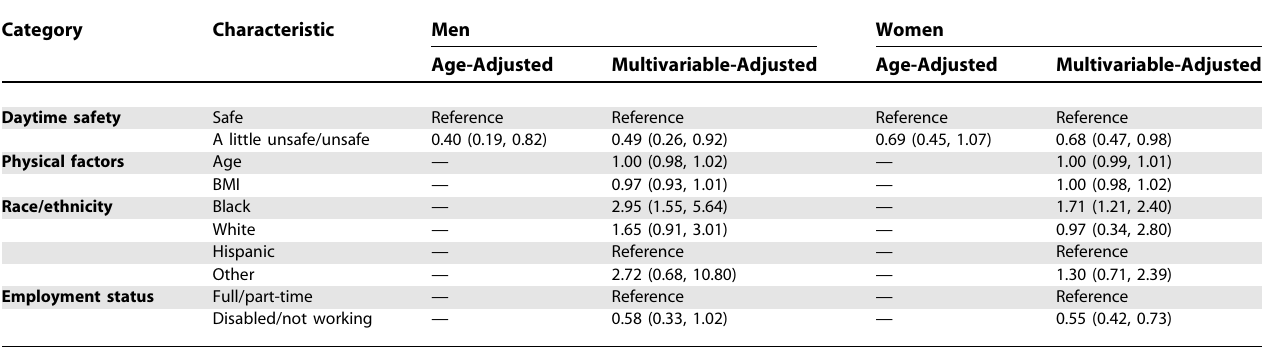
Table 5. Perceived Daytime Neighborhood Safety and Physical Activity Self-Efficacy, OR (95% CI)